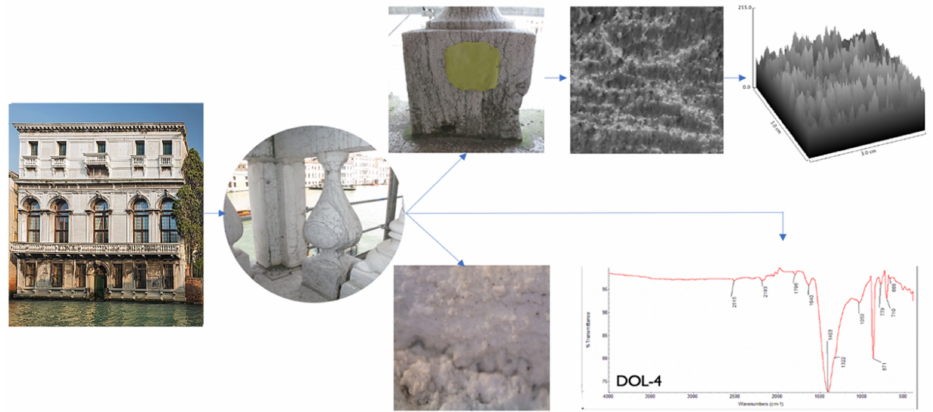
Figure 2. Graphical representation of morphological measurement methodology. Istria stone elements of the façade are selected, photographed, and observed with a portable microscope; rubber molds are casted and digitized; few milligrams of powder were sampled for FT-IR analysis. The micrographs measures 5 cm × 5